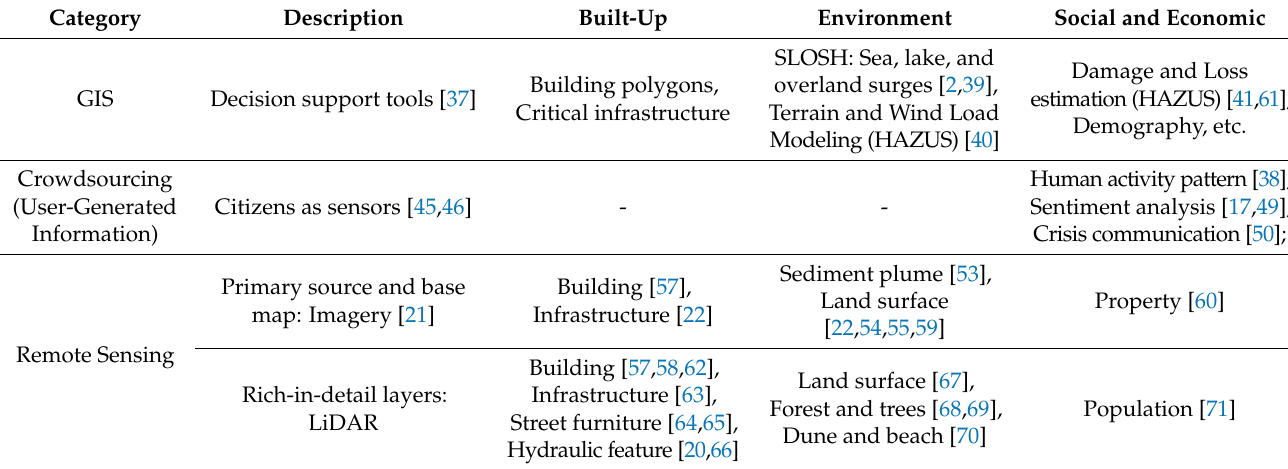
Table 3. Summary of different spatial data in addressing different dimensions of community resilience. Category Description Built-Up Environment Social and Economic SLOSH: Sea, lake, and Damage and Loss overland surges [2,39], Building polygons, GIS Decision support tools [37] estimation (HAZUS) [41,61], Terrain and Wind Load Critical infrastructure Demography, Modeling (HAZUS) [40]